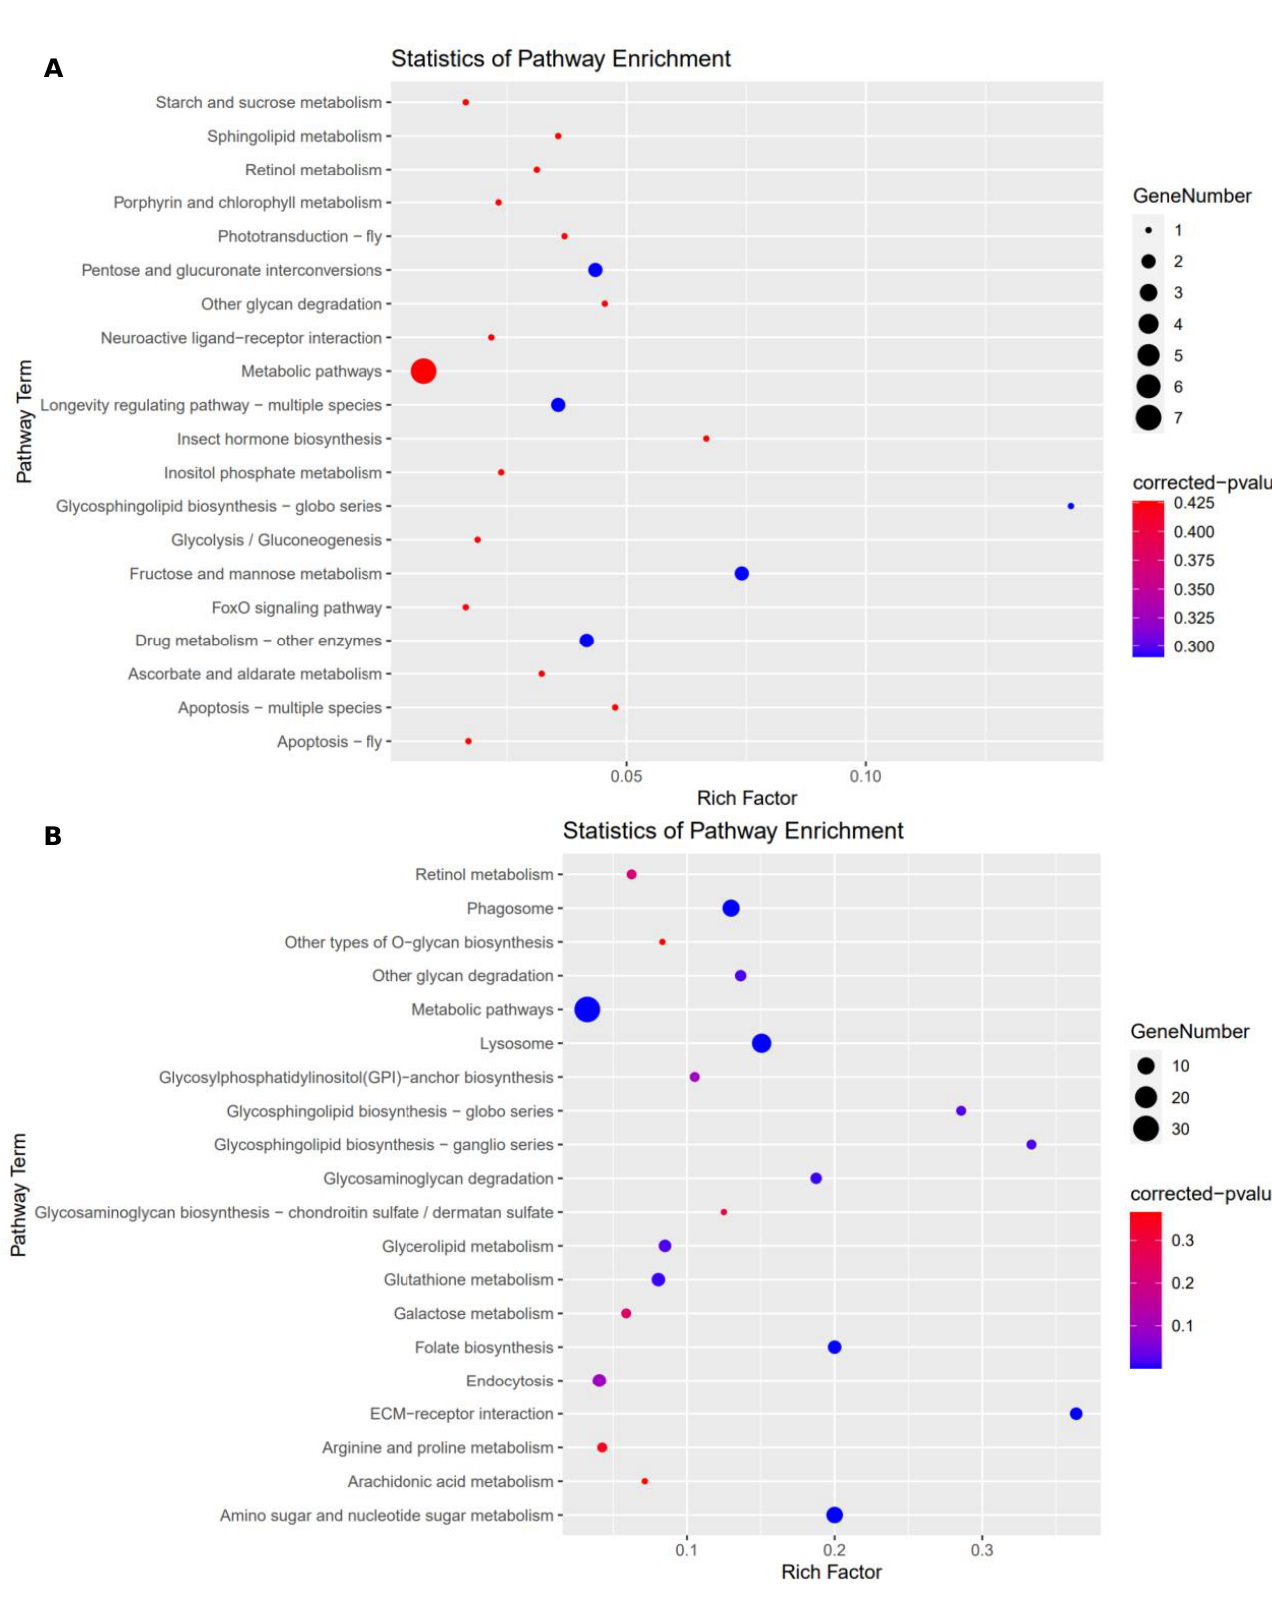
Figure 3. The KEGG significant enrichment pathway in HC_O vs. CG_O group. ( A ) Up − regulation